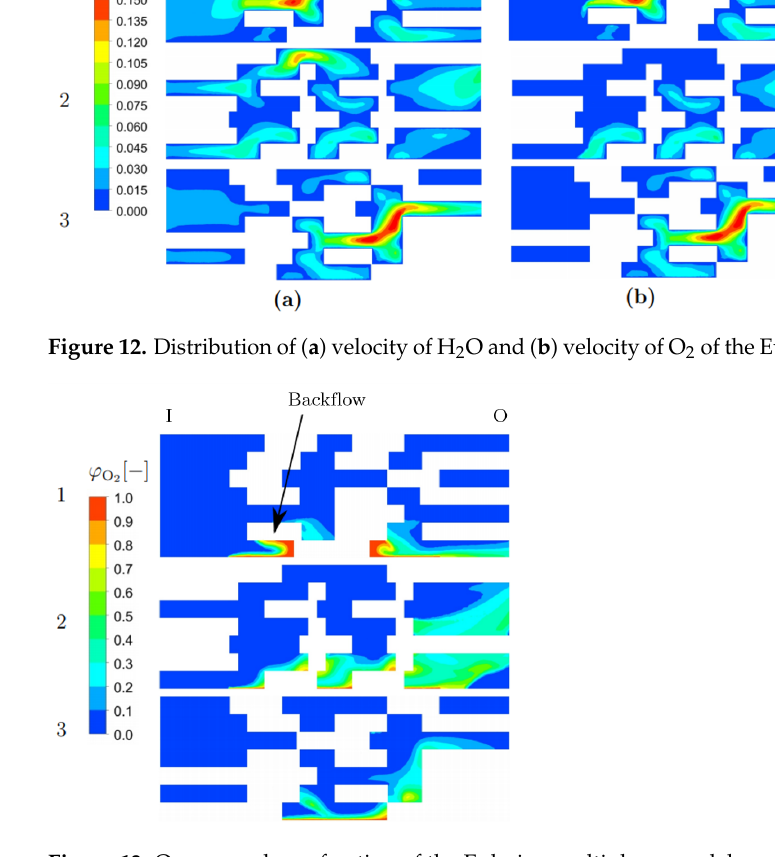
Figure 13. Oxygen volume fraction of the Eulerian multiphase